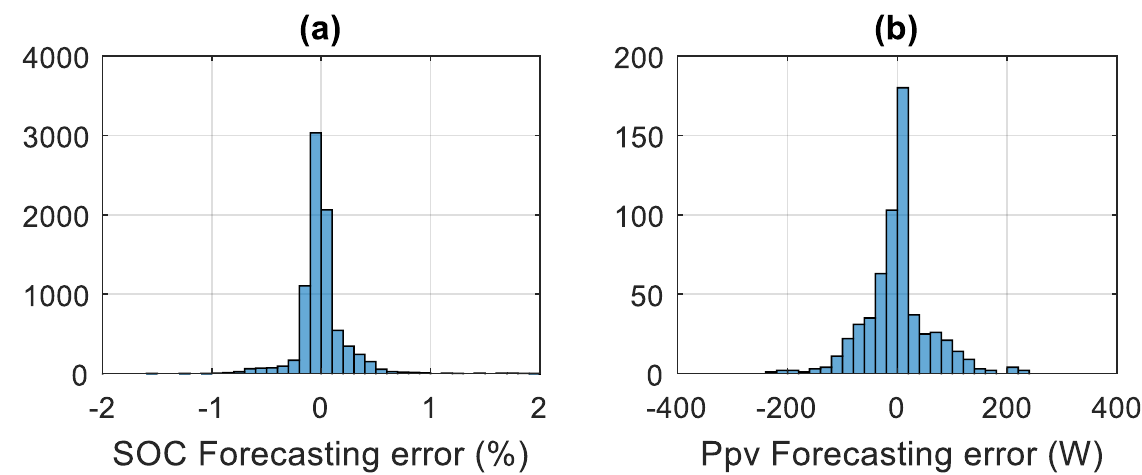
Figure 11. Yearly forecasting error: ( a ) histogram of PPV power forecasting error; ( b ) histogram of battery SOC forecasting error.